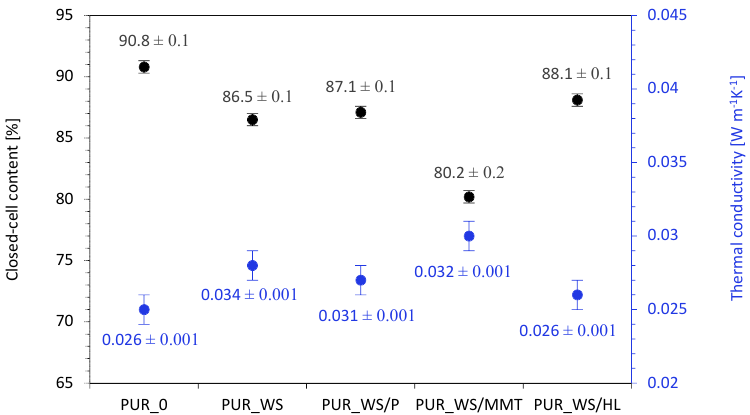
Figure 6. Closed-cell content and thermal conductivity results of PUR composites containing walnut shell fillers.